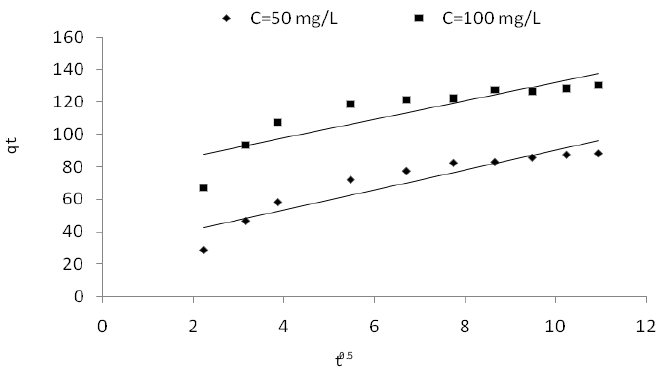
Figure 13. Weber–Morris kinetic model; Time 120 min, dose: 0.04 g/100 mL, pH 7. Table 3. Maximum adsorption capacity of some adsorbents for different